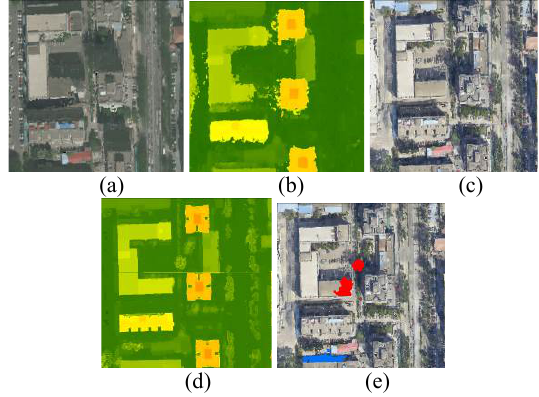
Figure 10. Pseudo-changes caused by SGM mismatching. (a) TDOM of 2015, (b) DSM of 2015, (c) TDOM of 2017, (d) DSM of 2017, (e) pseudo-changes caused by SGM mismatching of frame digital aerial